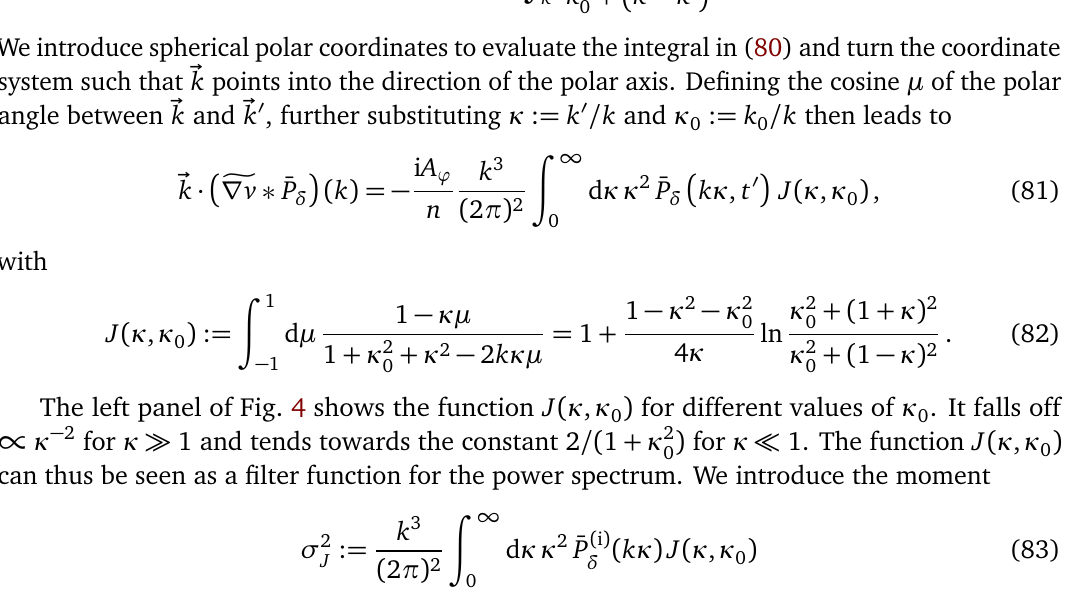
) appearing in the averaged force term 〈 ˜ f 0 . While the asymptotic behaviour of J ( κ , κ 0 ) approaches the value 2 / ( 1 + κ 2 , J ( κ , κ 0 0 〉 ( k ) as a function of the wave number k I